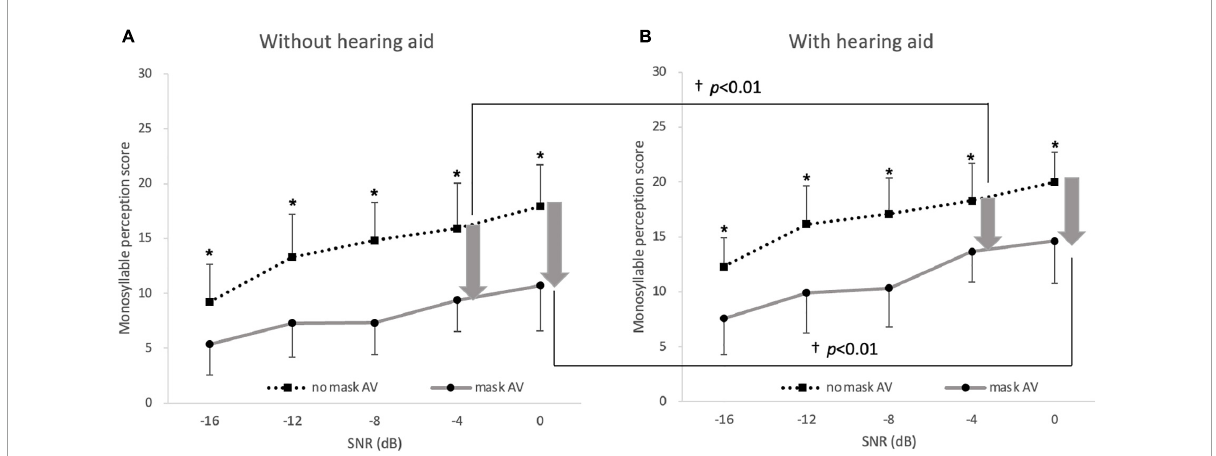
FIGURE4 Deterioration in monosyllabic speech perception in noise caused by mask. Speech perception was lower under the mask–AV conditions (filled circles) than under the no-mask–AV (filled squares) conditions (A) without hearing aids and (B) with hearing aids at all noise levels (* p < 0.003, accepted α = 0.003). The degree of deterioration in speech perception caused by a mask was significantly lower with hearing aids than without hearing aids at 0 and –4 dB SNR ( † p < 0.01, Bonferroni’s corrected α = 0.05/5 = 0.01). The arrow indicates the degree of deterioration in speech perception and the error bar indicates SD.